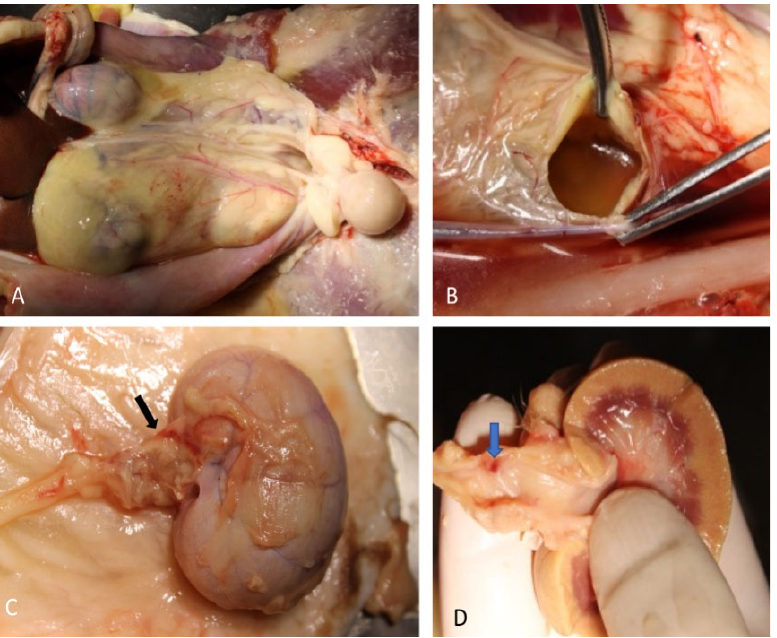
Figure 6. Macroscopic appearance of urinoma, ( A ) before and ( B ) after the incision. ( C ) Gross aspect of the left kidney and ureter with dilated pelvis (black arrow). At a longitudinal section of the left kidney, a pale parenchyma and an evident pyeloureteral ectasia were observed; a bright red lenticular area corresponding to the ureter rupture point (blue arrow) was observed ( D ).